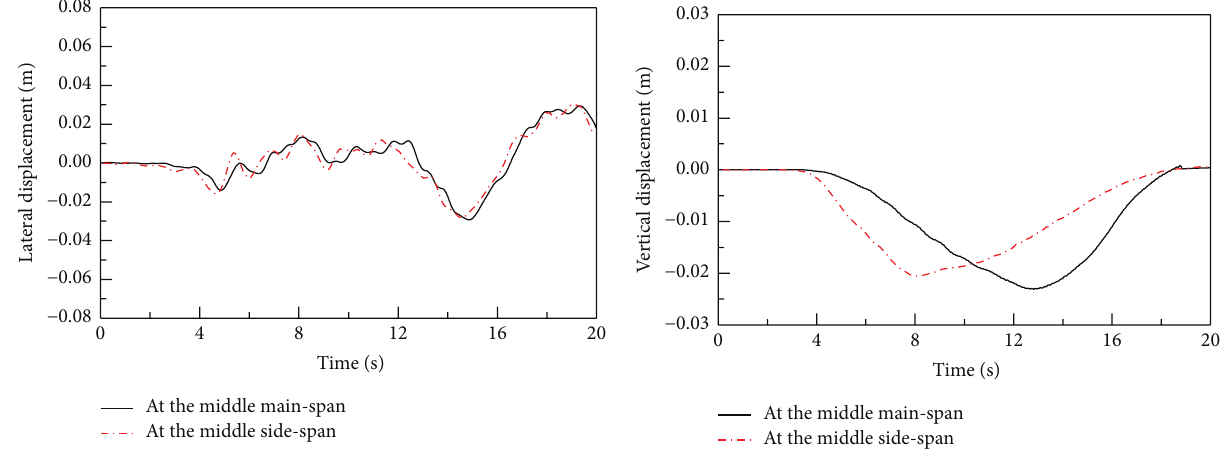
Figure 10: Time histories of lateral and vertical displacements of the